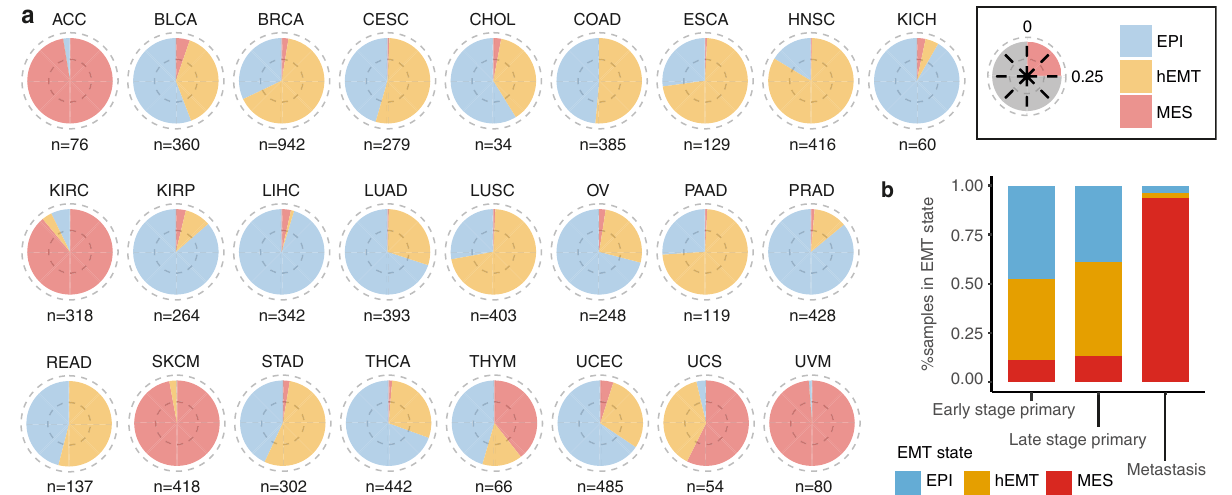
Fig. 2 | Pan-cancer distribution of EMT macro-states. a Distribution of the EMT states across different cancer tissues. The fraction of EPI, MES and hEMT samples areindicatedindifferentcolours.Eachquarterofthepiecorrespondsto25%ofthe data. The number of samples analysed is indicated for each tissue. Tissue